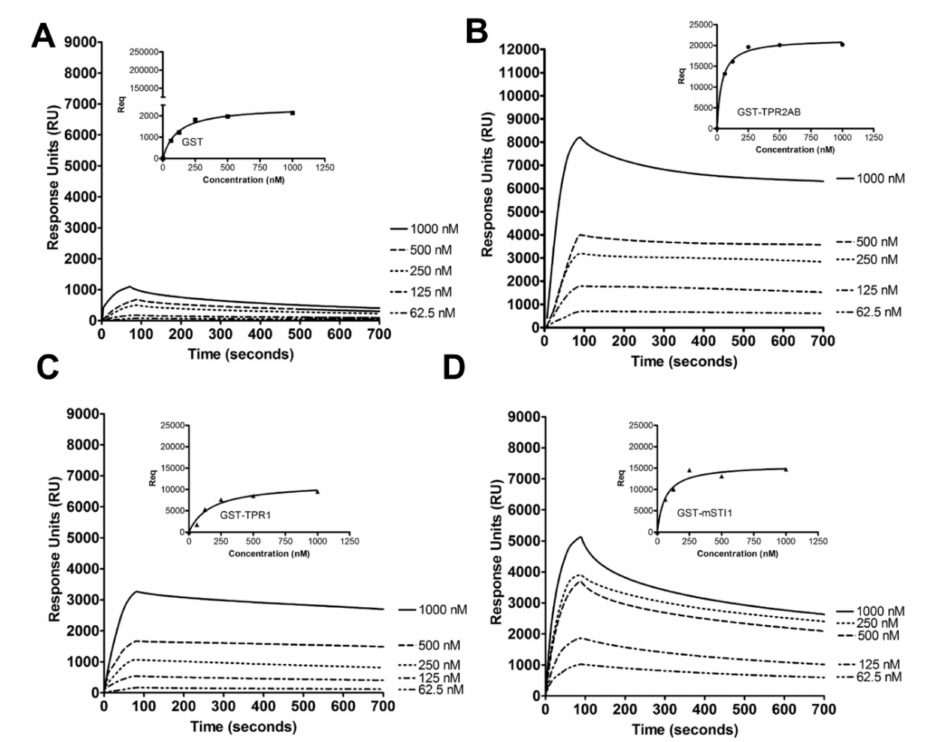
Figure 2. The TPR2AB-DP2 domain of mSTI1 interacts with actin. Surface plasmon resonance (SPR) analysis of binding of ( A ) GST, ( B ) GST-TPR2AB, ( C ) GST-TPR1 and ( D ) GST-mSTI1 to immobilised actin. Data shown are representative of two independent experiments repeated in triplicate. Insets show plots of Req versus mSTI1